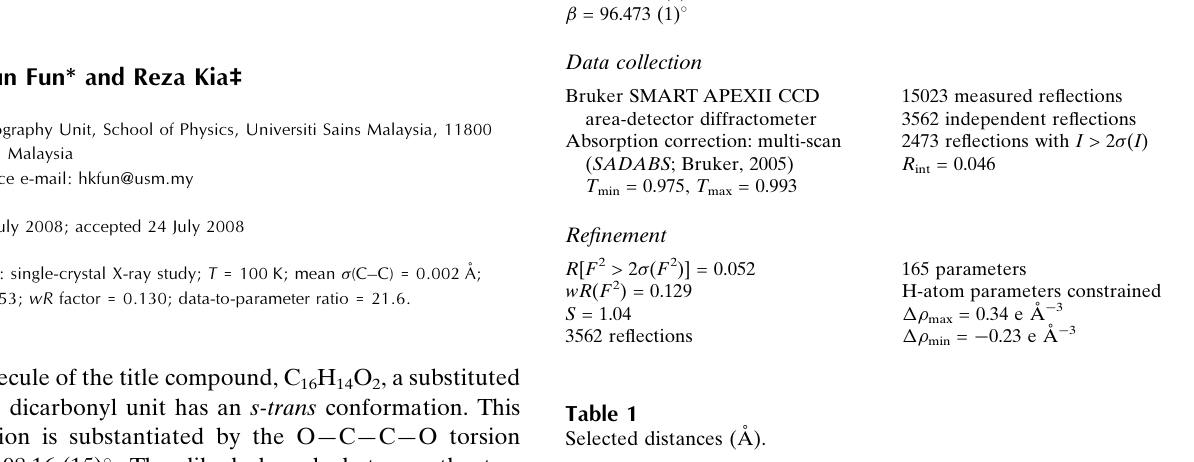
Selected distances (A˚ ).